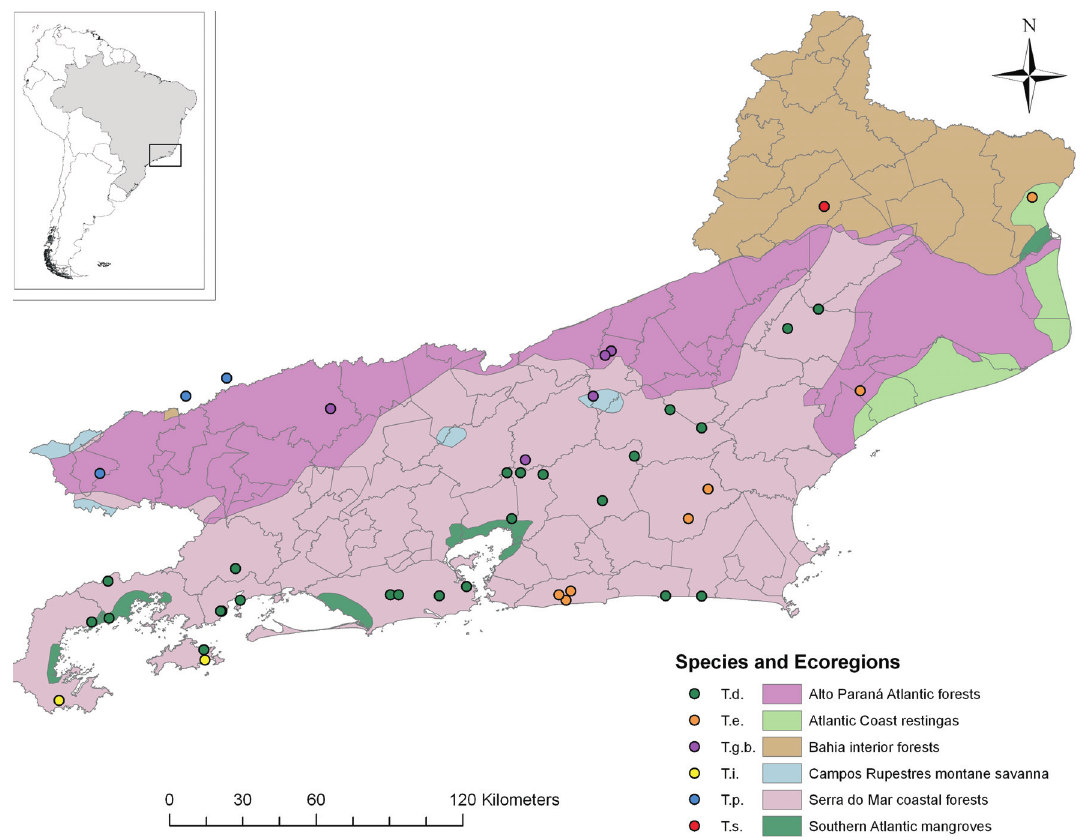
Figure 2. Map of Rio de Janeiro State, divided in ecoregions, showing the records from the literature and the present study for the six Trinomys